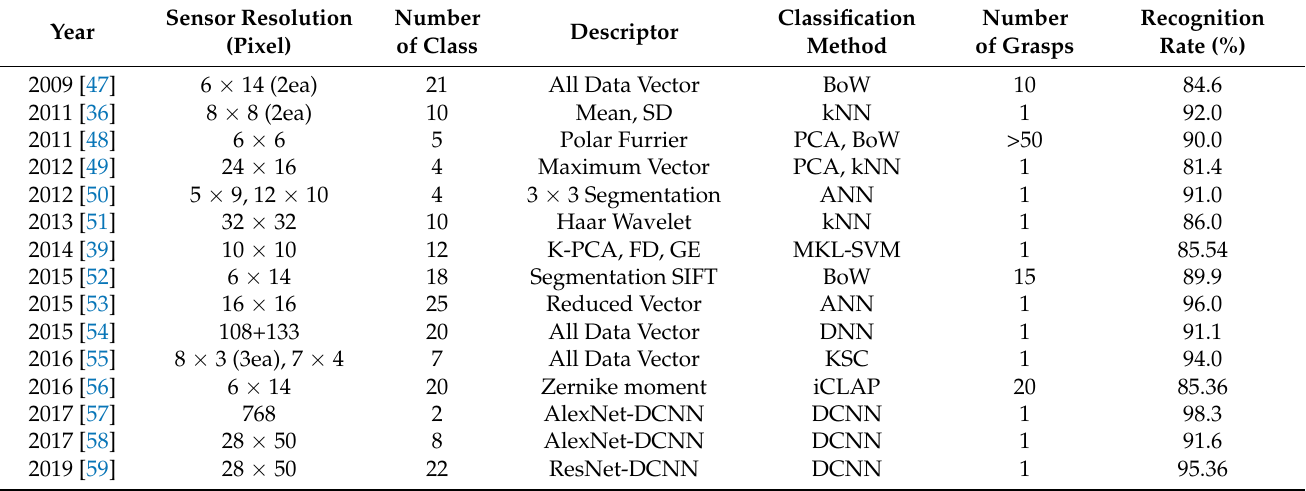
Table 2. Tactile image recognition for robot